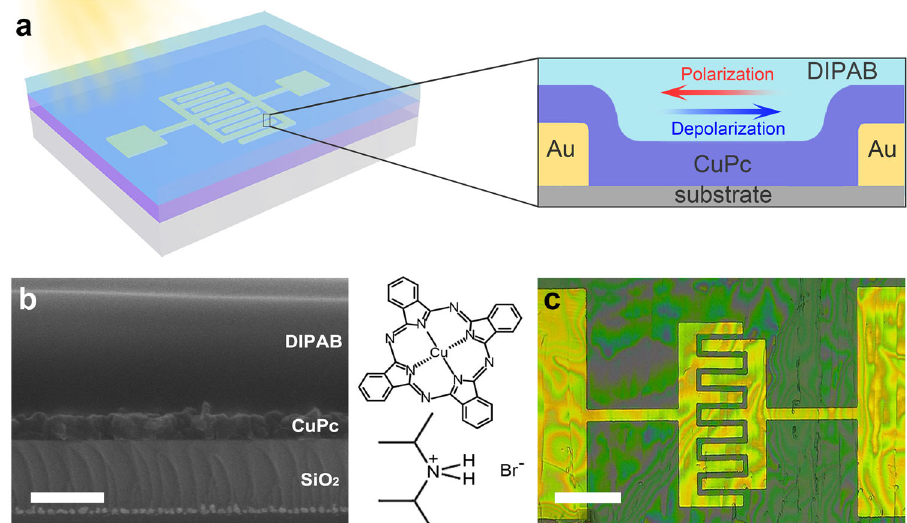
Fig. 1 Concept diagram and device characteristics. a 3D and cross-sectional structure of the interfacial device. b Cross-sectional SEM image of the devices. The scale bar is 200 nm. The insets show the molecular structures of CuPc and DIPAB, respectively. c An optical micrograph of a single device with a scale bar of 30 μ